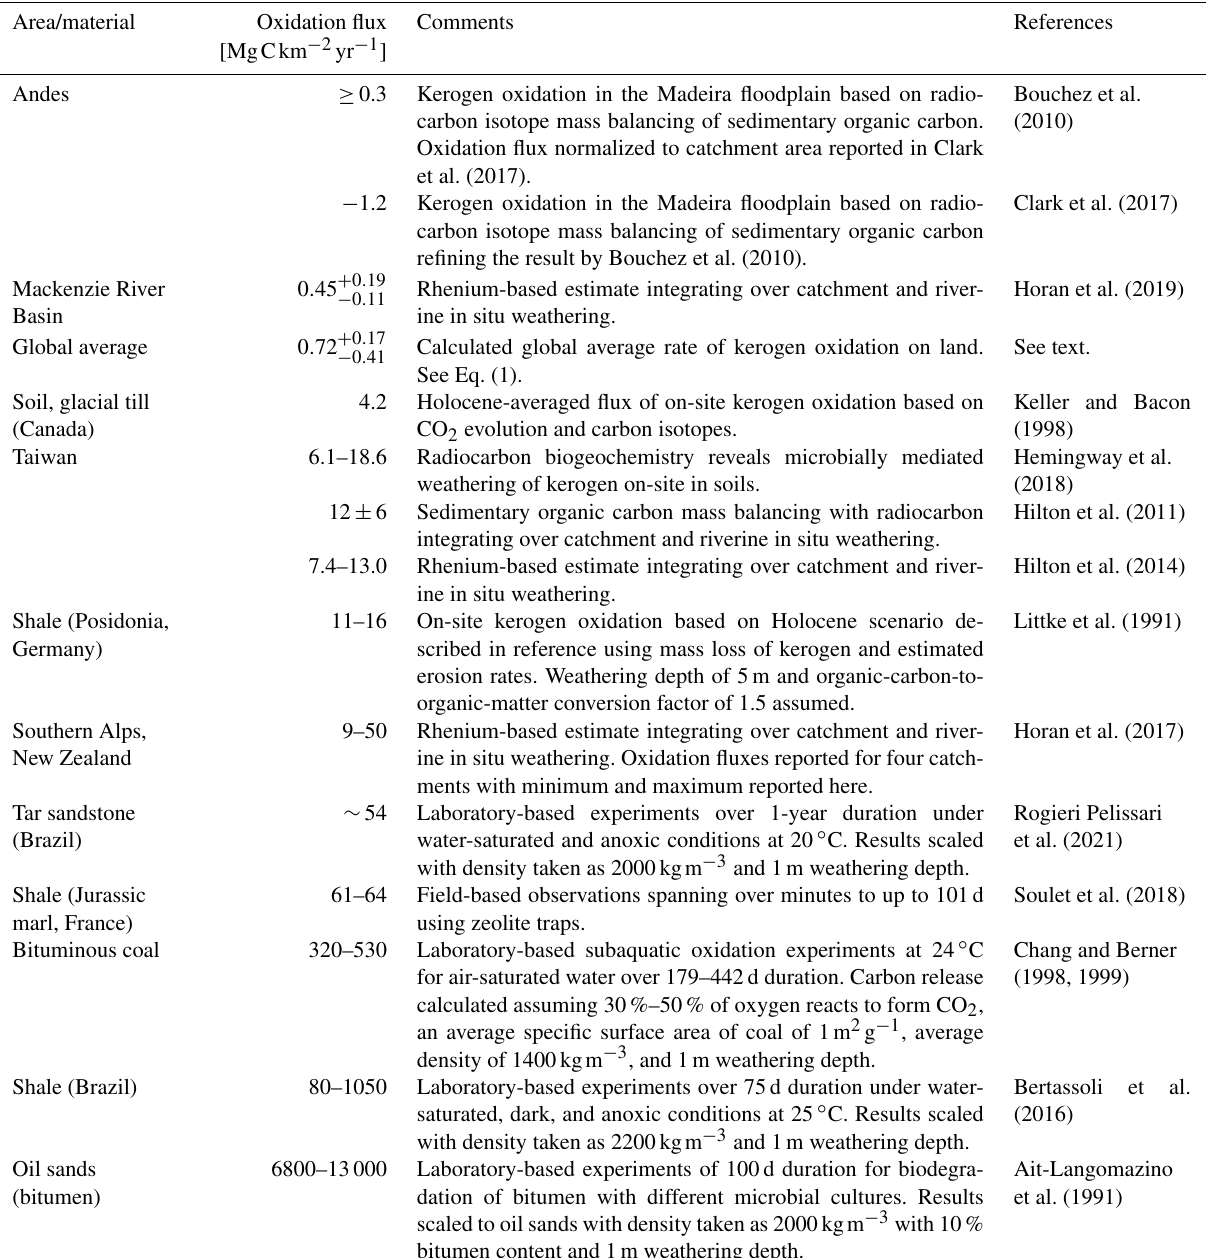
Table 2. Fluxes of kerogen oxidation normalized to 1 year from on-site (soil and outcrops), catchment-wide studies (river), and laboratory- based incubation studies ordered approximately from small to large CO 2 release fluxes. For calculations, see the